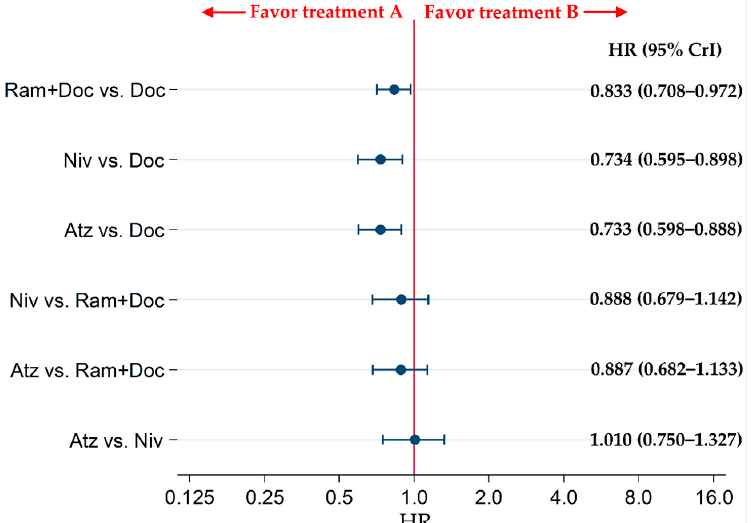
Figure 4. Comparing the OS of patients with refractory or relapsed advanced non-squamous non- small-cell lung cancer in the Ram+Doc, Doc, Niv and Atz groups. The patient inclusion criteria for